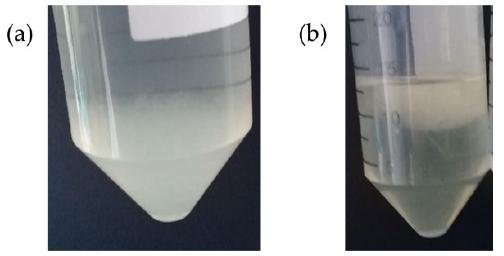
Figure A6. Alginate aggregates re-suspended from samples of culture #1 taken after ( a ) 30 h and ( b ) 51 h since the inoculation.